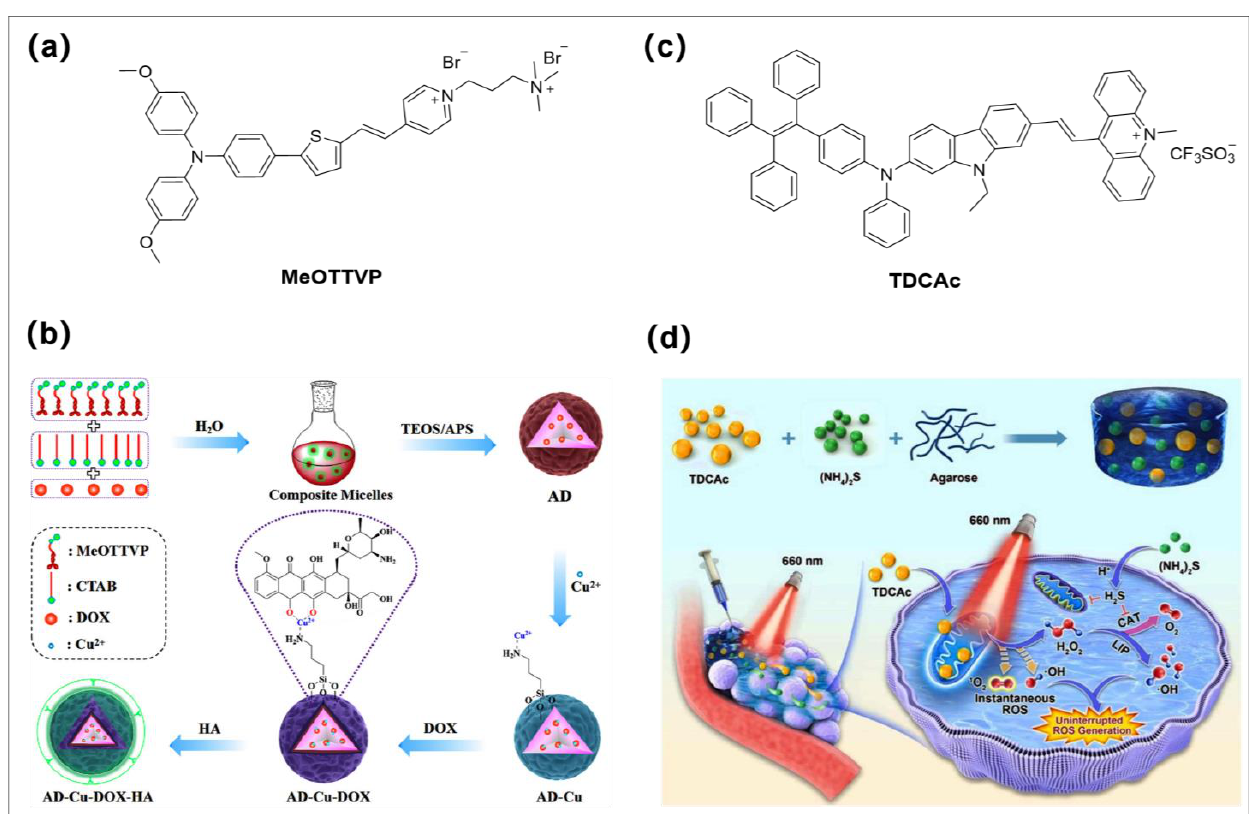
Figure 6. ( a ) and (b) are chemical structure of MeOTTVP and the schematic representation of the steps involved in making AD-Cu-DOX-HA , respectively. Reprinted with permission from [76]. ( c ) and (d) are the chemical structure of type I AIE PS ( TDCAc) and schematic illustration of type I PDT combined with H 2 S gas treatment for indigenous LIP-mediated continuous OH •− generation in the tumor, respectively. Reprinted with permission from [83].